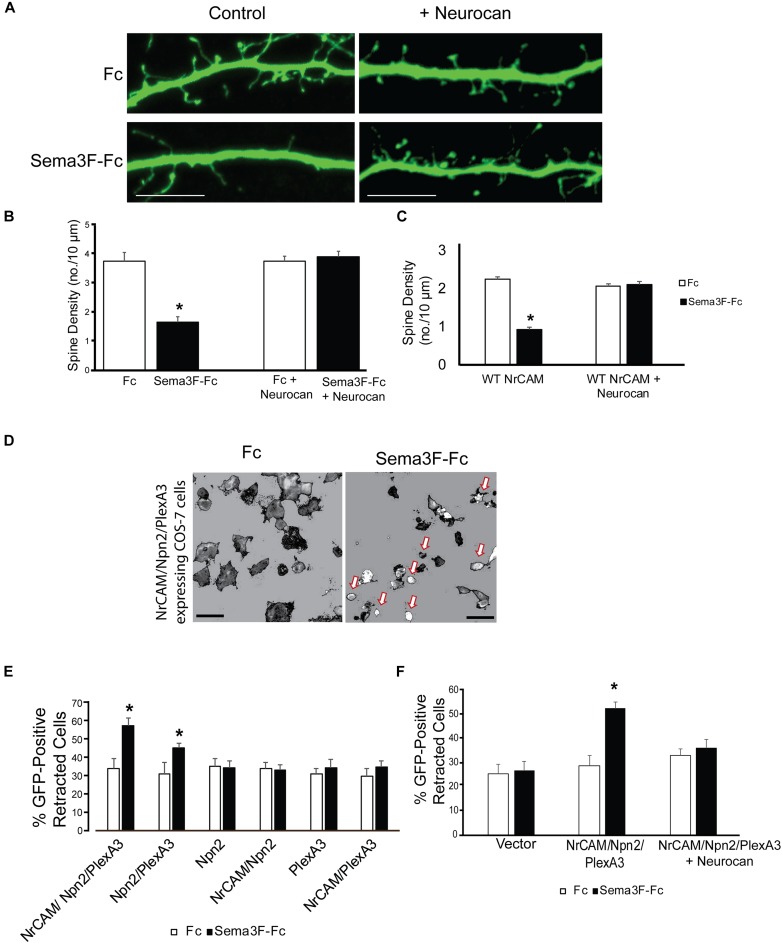
Neurocan inhibits Sema3F-induced spine and cell retraction. (A) Apical dendrites and spines of mouse cortical neurons expressing EGFP in cultures treated with Fc or Sema3F-Fc for 30 min. Pretreatment with 20 nM Neurocan for 30 min prevented Sema3F-Fc induced spine collapse but did not affect spine density in Fc-treated control cultures. Scale bar = 10 μm. (B) Quantification of experiment in panel A, showing significant reduction in mean spine density upon Sema3F-Fc treatment by Neurocan (n = 3, 10 neurons per condition; ∗p < 0.05, t-test). (C) Treatment with 8 nM Neurocan for 30 min also prevented Sema3F-Fc induced spine collapse and did not affect spine density in Fc-treated control cultures (n = 3, 10 neurons per condition; ∗p < 0.05, t-test). (D) Representative thresholded images showing morphological retraction of COS-7 cells expressing NrCAM, Npn2, PlexA3, and EGFP after Sema3F-Fc treatment compared to Fc. Arrows point to retracted cells. Scale bar = 100 μm. (E) Quantification of morphological cell retraction after Fc or Sema3F-Fc treatment of COS-7 cells expressing NrCAM, Npn2, and/or PlexA3 and EGFP in panel D. Results show percent retracted cells (n = 3 assays, ∗p < 0.05, and t-test). (F) Quantification of morphological retraction upon Fc or Sema3F-Fc treatment of COS-7 cells expressing NrCAM, Npn2, and PlexA3 with and without pre-treatment with 20 nM Neurocan for 30 min (n = 3 assays, ∗p < 0.05, and t-test).